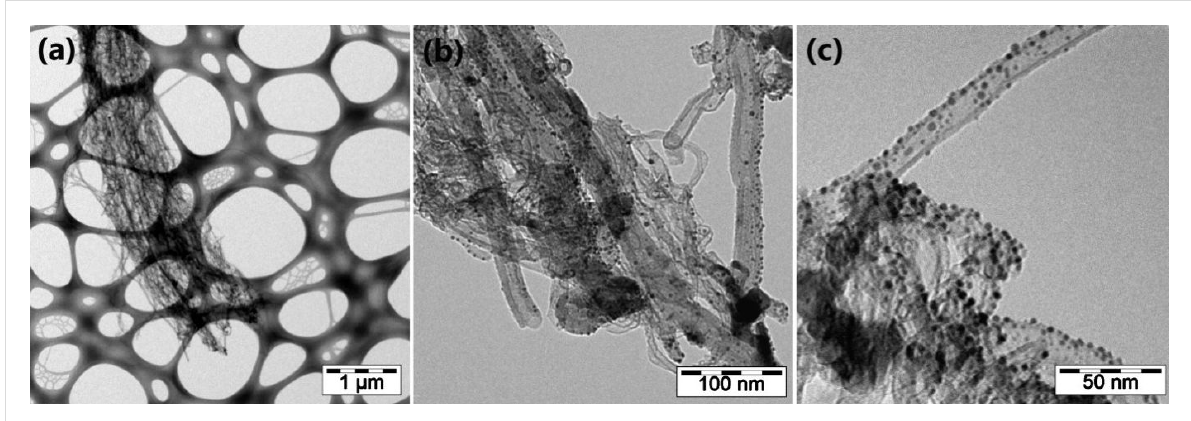
Figure 5: TEM images of VA-CNTs decorated with gold nanoparticles.